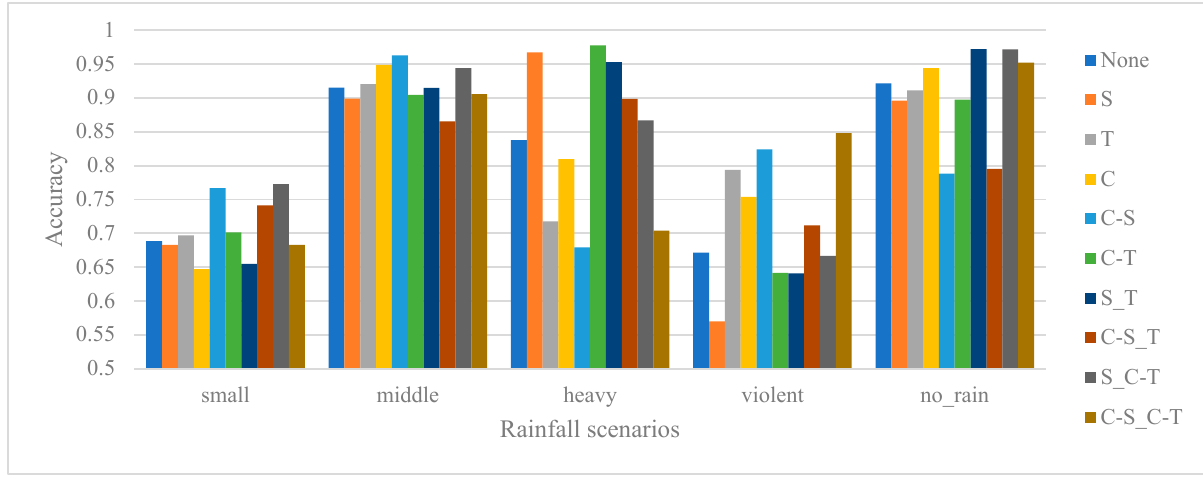
Figure 9. Comparison of accuracy for different attention mechanisms (C = Channel Attention, S = Spatial Attention, T = Temporal Attention; “-“ denotes the same branch, and “_” denotes different branches).